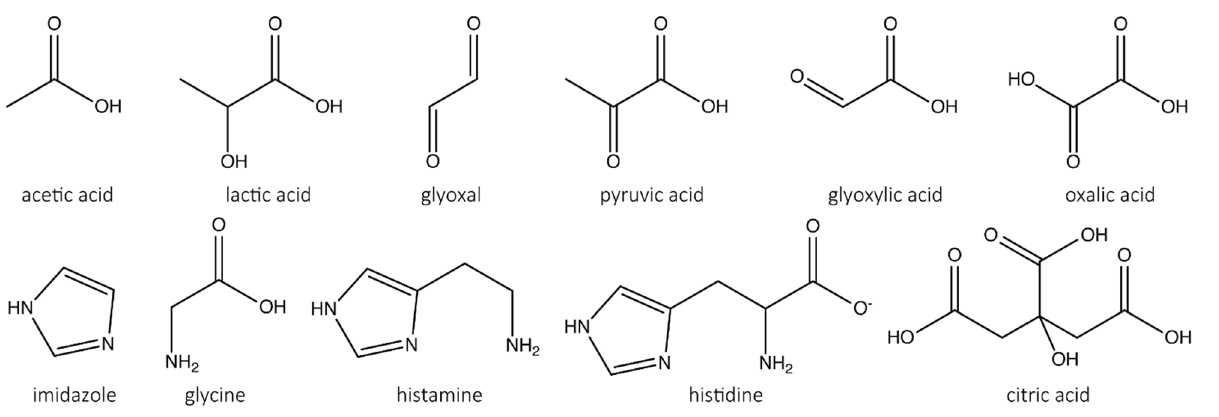
Figure 2. Mono-, di-, and tricarboxylic acids and amino acids or derivatives employed in the screening assay. Table 2. Comparison of specific and residual activities of Nc